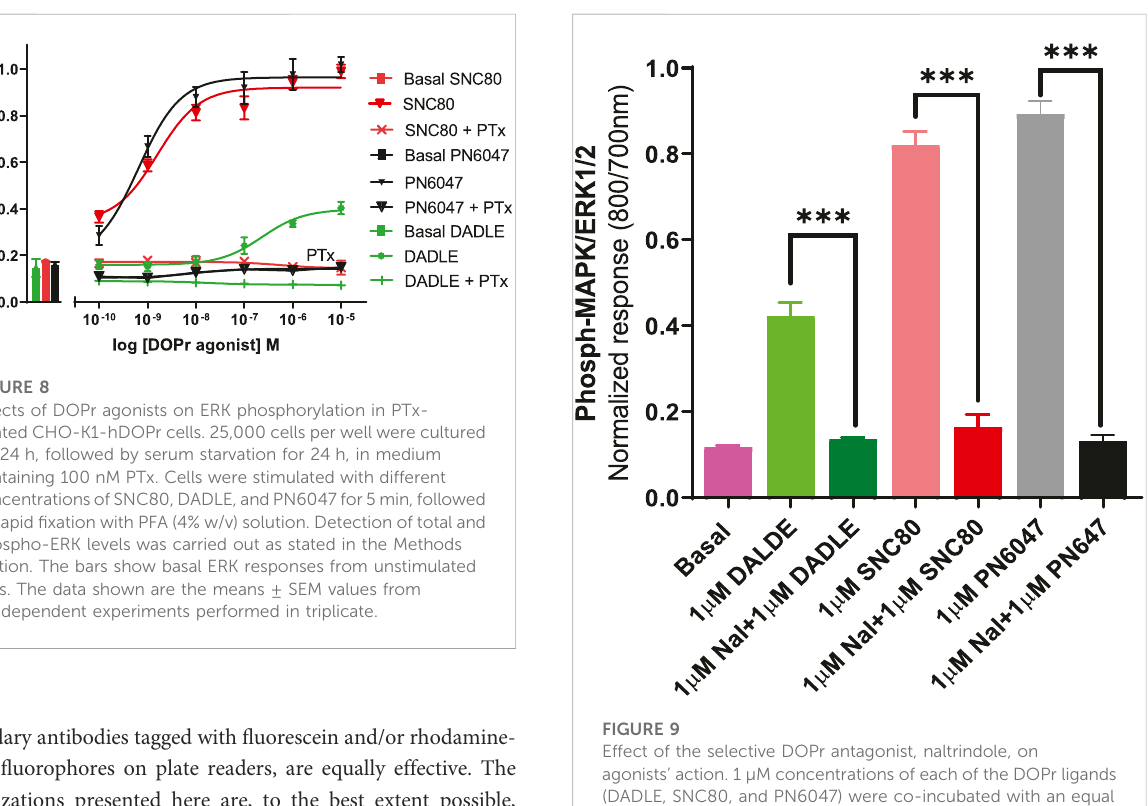
FIGURE 9 Effect of the selective DOPr antagonist, naltrindole, on agonists ’ action. 1 µM concentrations of each of the DOPr ligands (DADLE, SNC80, and PN6047) were co-incubated with an equal concentration of naltrindole in CHO-K-1- hDOPr cells. The data shown are the means ± SEM values from 3 independent experiments performed in triplicate. Statistical signi fi cance was determined using one-way ANOVA; *** p <